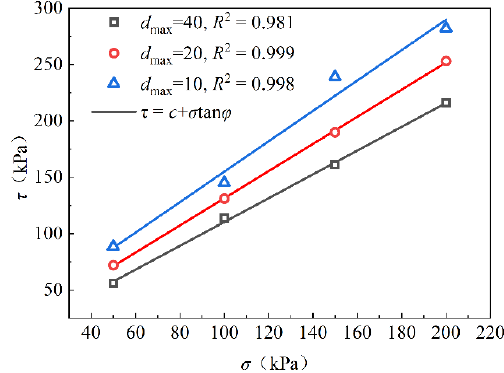
Figure 7. Relationship between internal axial pressure and shear strength of test